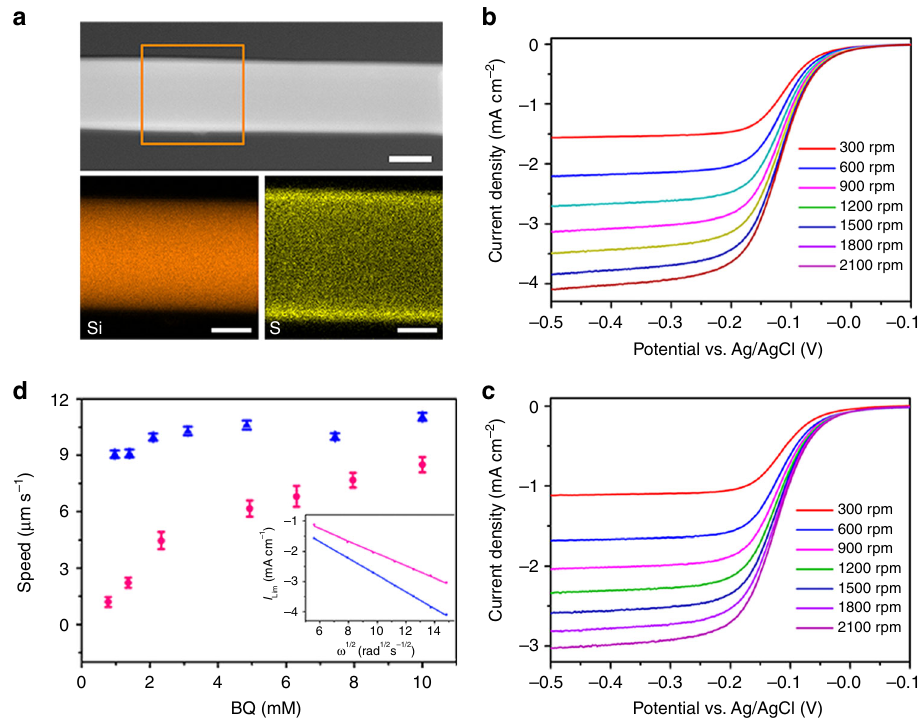
Fig. 2 Element analysis and electrochemical characterization of the microswimmers. a STEM and Energy-dispersive X-ray spectroscopy (EDX) mapping images of the SPS coated silicon nanowire; scale bar is 50 nm. The brown window in STEM image indicates the elemental mapping area. b , c Rotating disk electrode (RDE) voltammogram of the bare silicon and the SPS-coated silicon wafer in 2 mM BQ and 1 M KCl aqueous solution. The scanning rate is 10 mV s − 1 . Rotation speeds are 300, 600, 900, 1200, 1500, 1800, and 2100 rpm, respectively. d Migration speed vs. the BQ ’ s concentration of bare microswimmer (blue) and SPS coated microswimmer (red). The inset is the Levich plot of the bare silicon (blue) and the SPS coated silicon wafer (red) at − 0.5 V vs.